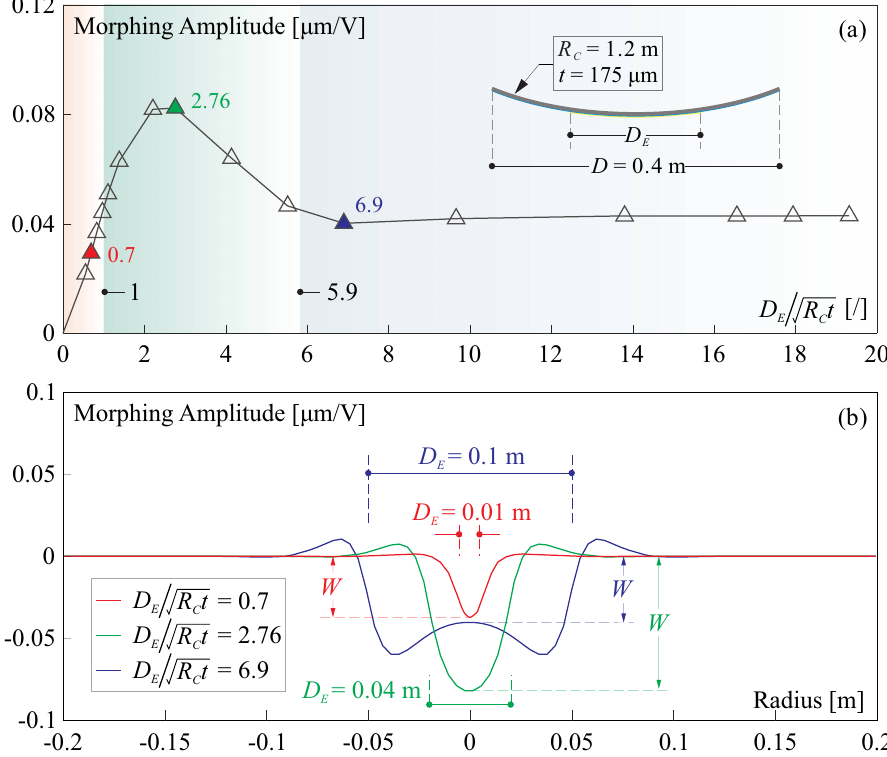
Figure 6. ( a ) The evolution of the morphing amplitude excited by a unit voltage with respect to √ R C t , where the amplitude is measured by the relative the dimensionless geometric factor D E / displacement of the center of the shell structure; ( b ) the cross section shows different morphing √ R C t behaviors of various D E /